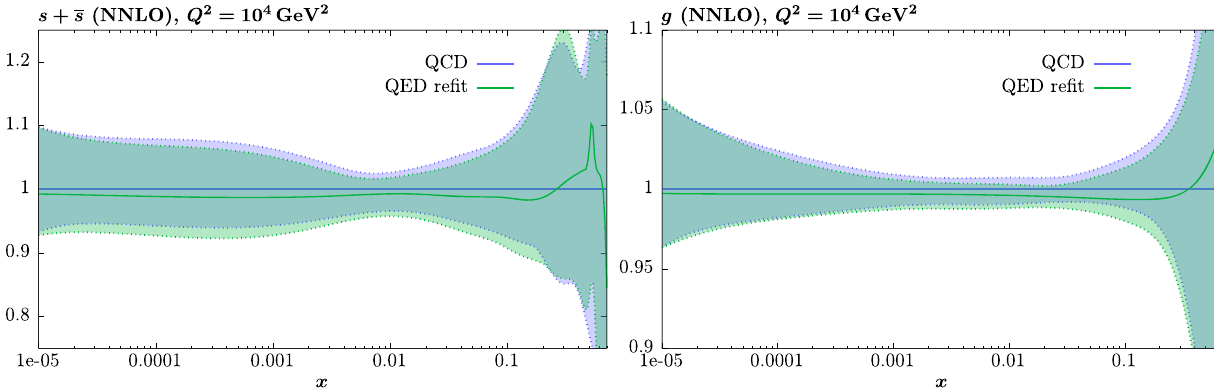
in the MMHT15qed set, and therefore we show only a selection here. In all cases, these correspond to the scale Q 2 = 10 4 GeV 2